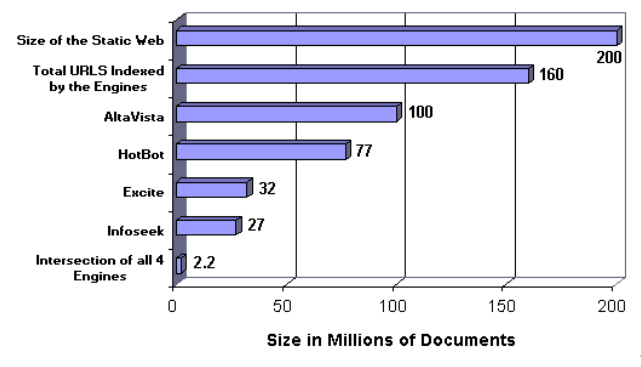
Figure 4. Size of static web pages in 1997 as in